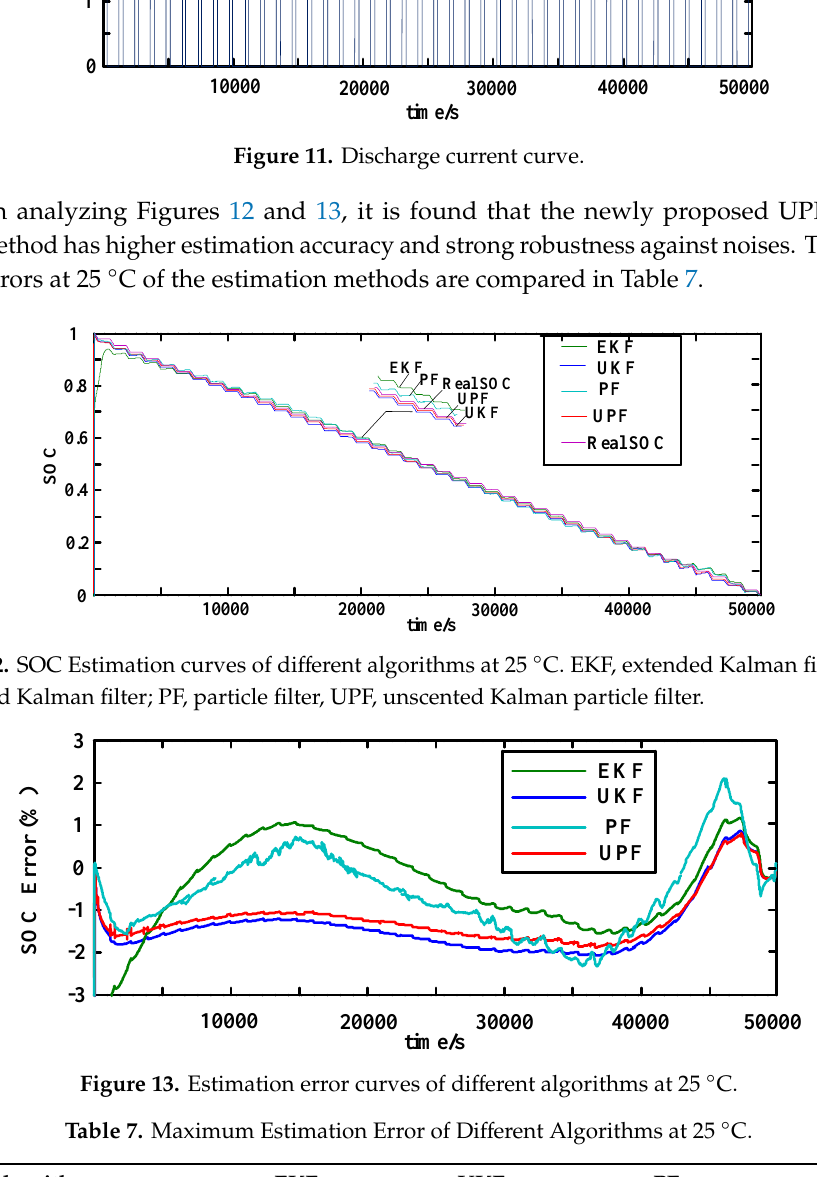
Table 7. Maximum Estimation Error of Different Algorithms at 25 °C.